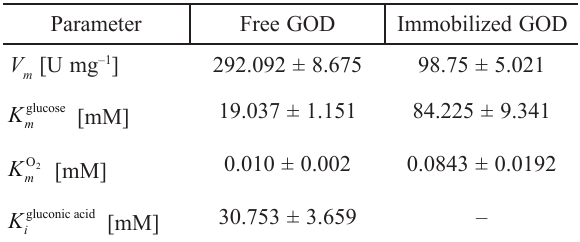
Table 2 – Kinetic parameters of glucose oxidation catalysed by free and immobilised GOD (0.1 M phosphate buffer pH